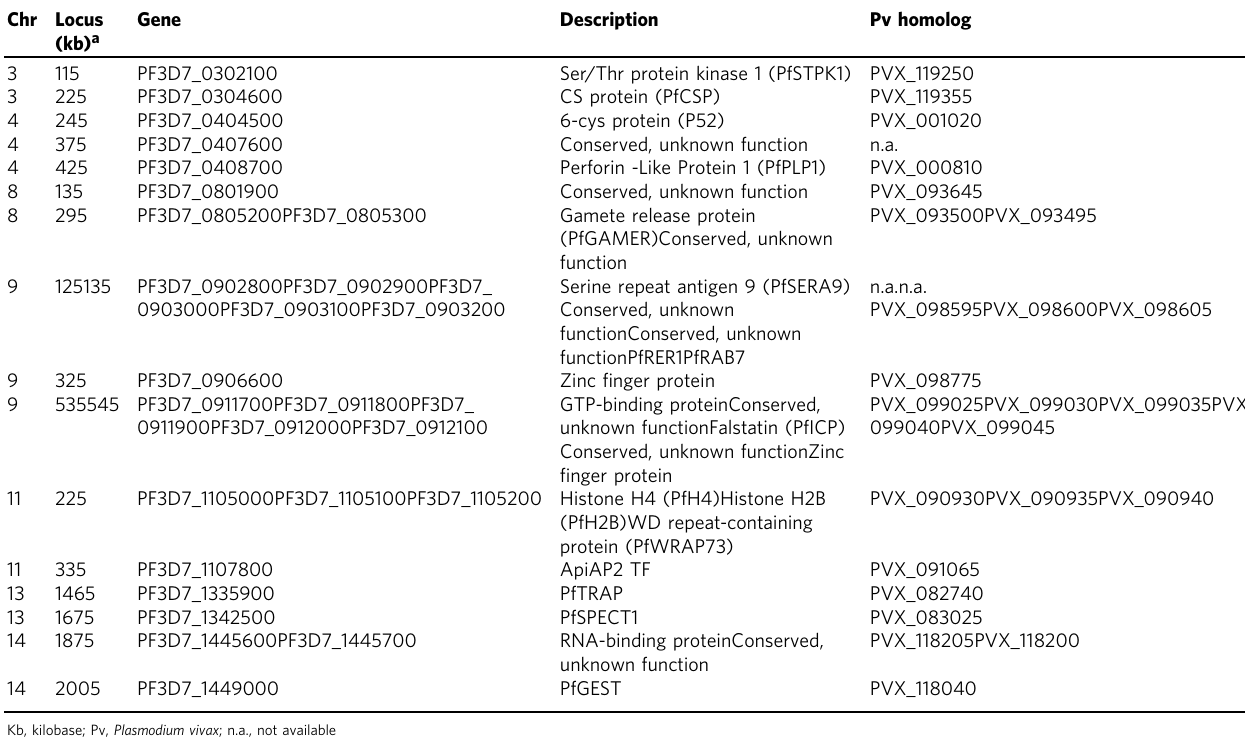
Table 1 Loci involved in long-range intrachromosomal interactions in P. falciparum sporozoites Chr Locus (kb)